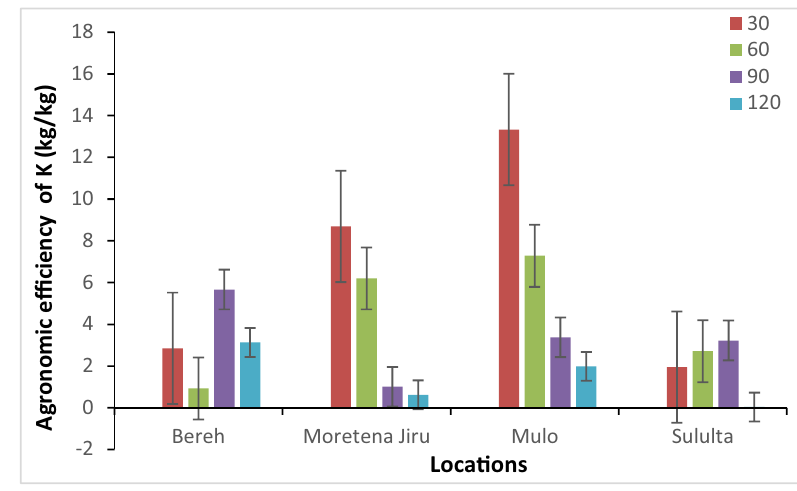
Figure 5: Agronomic e ffi ciency of K application for the te ff grain